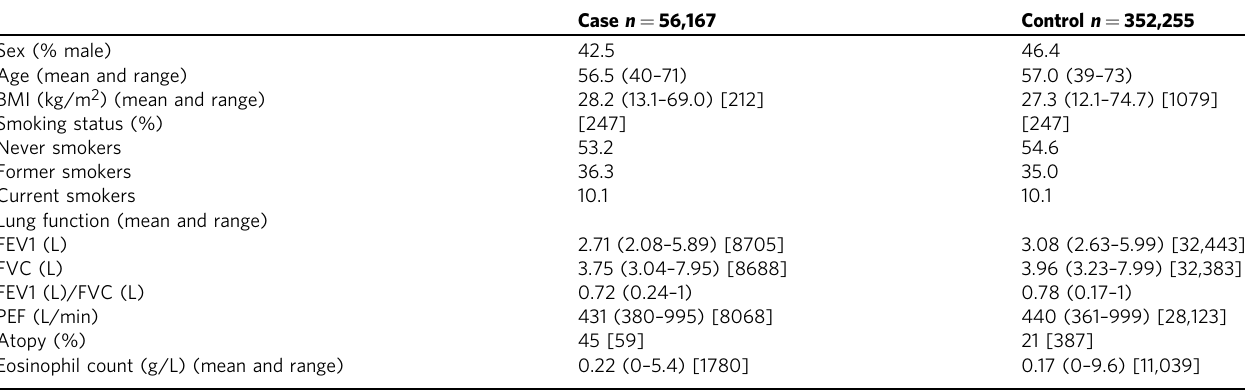
Table 1 Demographics and clinical characteristics of asthma cases and controls in the UK